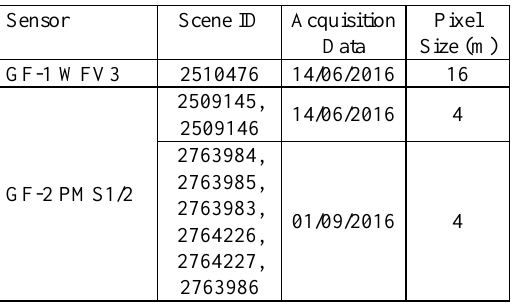
Table 1 . GF-1 and GF-2 data used in the